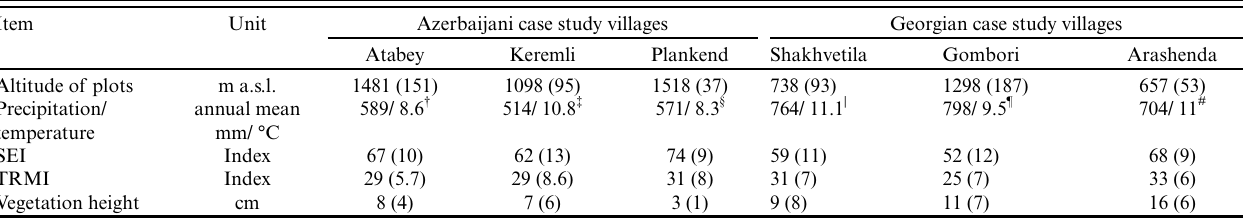
Table 4 . Indicators for pasture productivity based on online resources and plot information. Item Altitude of